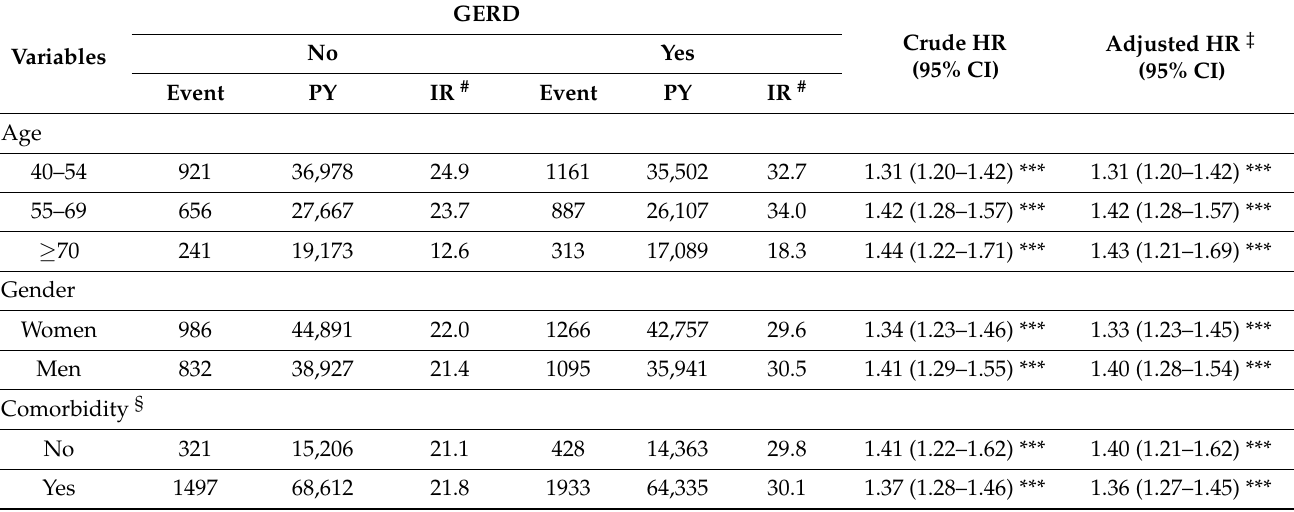
Table 3. Incidence rates and hazard ratios of periodontitis for individuals with and without GERD.